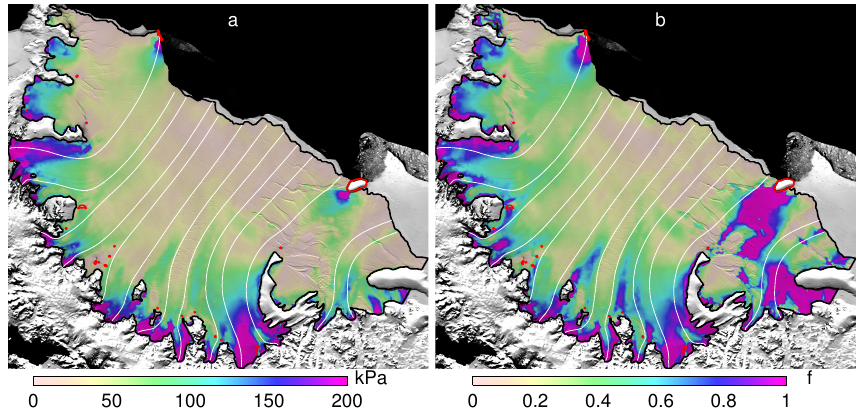
Fig. 5. (a) Backstress σ b from Eq. (16); (b) buttressing parameter f from Eq. (18). Red spots and contours indicate patches of grounded ice. Both panels plotted over 2009 MOA